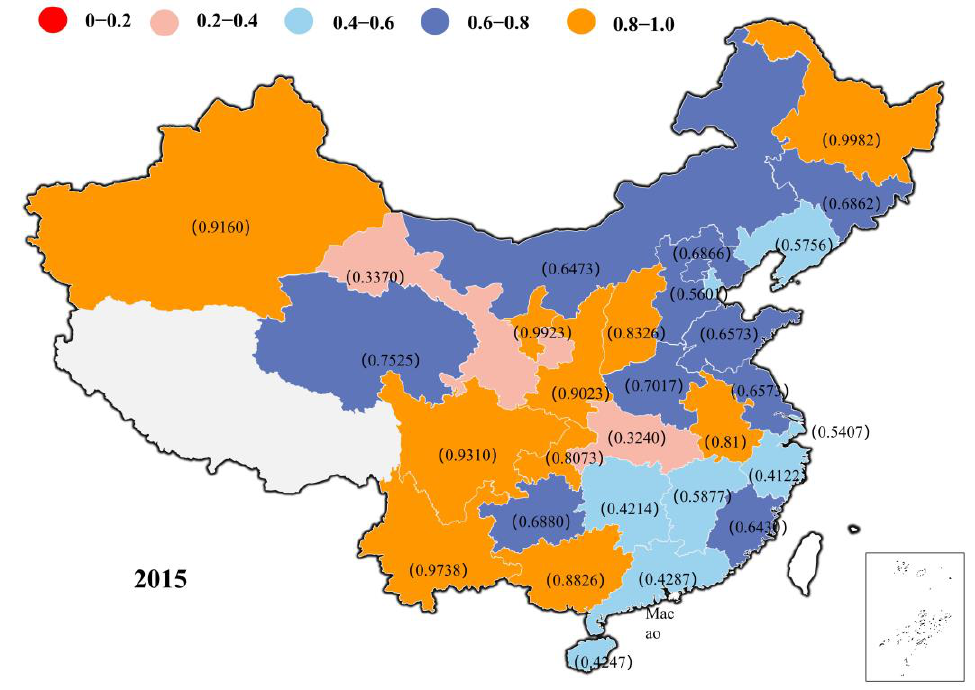
Figure 9. Spatial patterns of CERI scores in 2015 in 30 Chinese provinces.